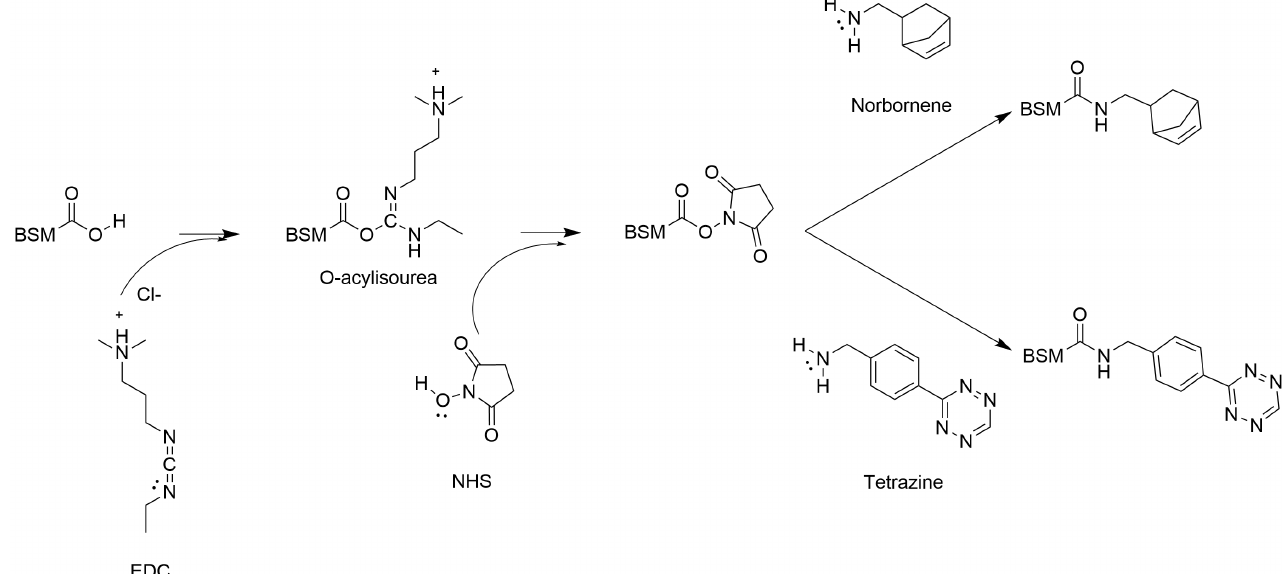
Figure A3. EDC NHS coupling (simplified).